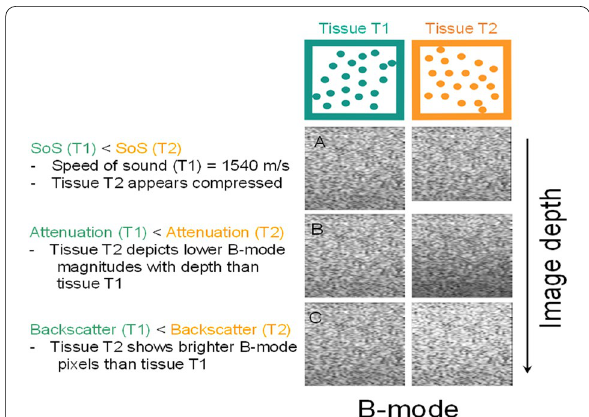
Fig. 8 Simple interpretation of QUS imaging modes. Tissues T1 and T2 when interacting with a compression wave emitted by the transducer are characterized by different QUS properties evaluated by the speed of sound (SoS), attenuation, and backscatter coefficient measures. The interpretation of QUS parameters in this example is based on the B-mode representation of the tissue. a Compared with a reference tissue T1 that has a speed of sound of 1540 m/s, tissue T2 that has a higher speed of sound would appear compressed because distances on clinical ultrasound systems are measured with the assumption that all tissues behave with an SoS 1540 m/s. b Tissue = T2 that has a higher attenuation would appear hypoechoic in deeper locations. c Tissue T2 that has a higher backscatter would appear hyperechoic on B-mode